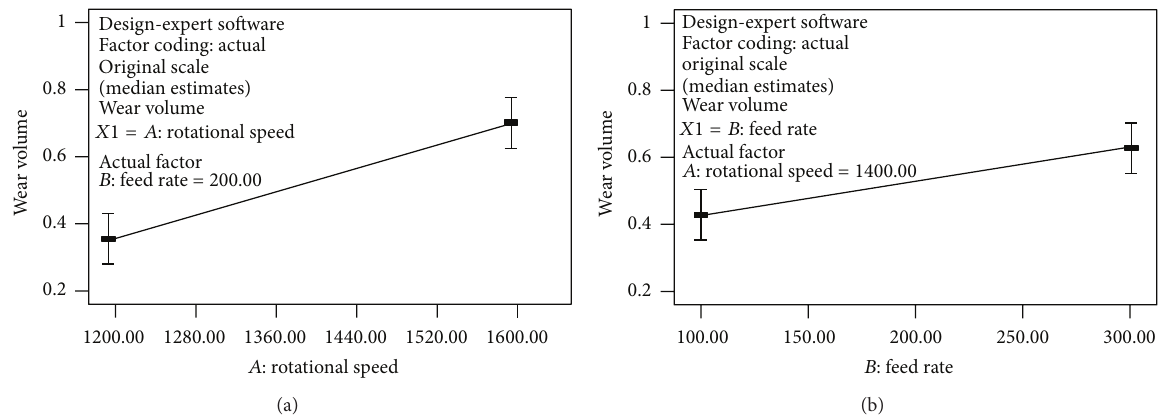
Figure 11: Main effect plot of (a) wear volume against rotational speed and (b) wear volume against feed rate.